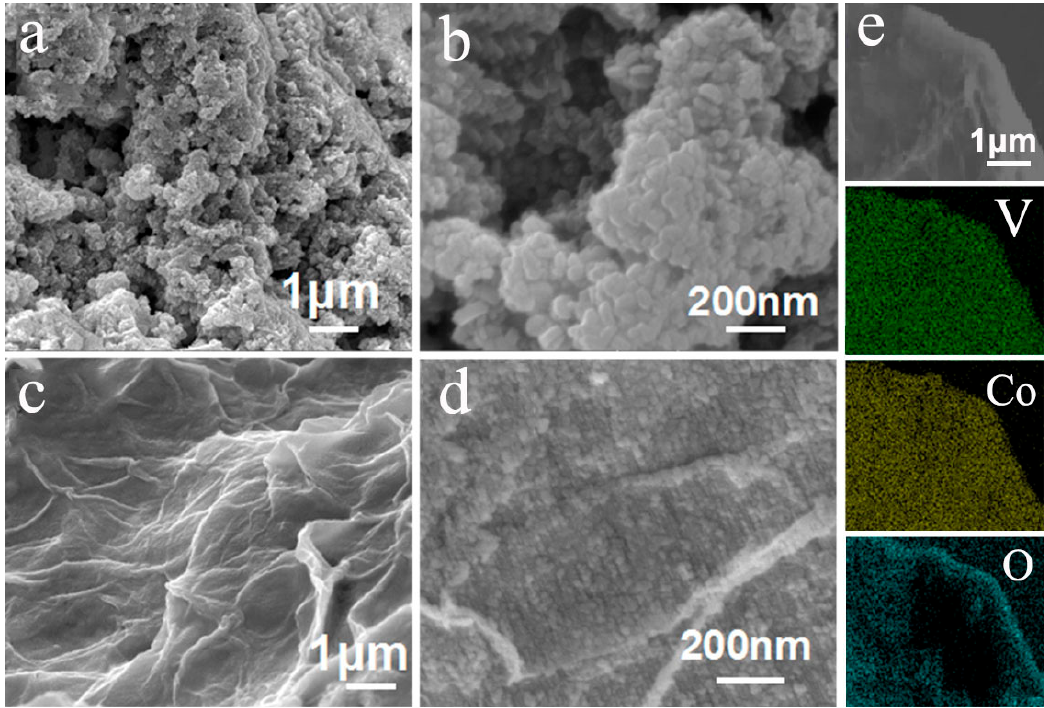
Figure 2. FESEM images of ( a , b ) CVO nanoparticles and ( c , d ) rGO@CVO composite. ( e ) EDX mapping images of V, Co and O in the rGO@CVO composite.